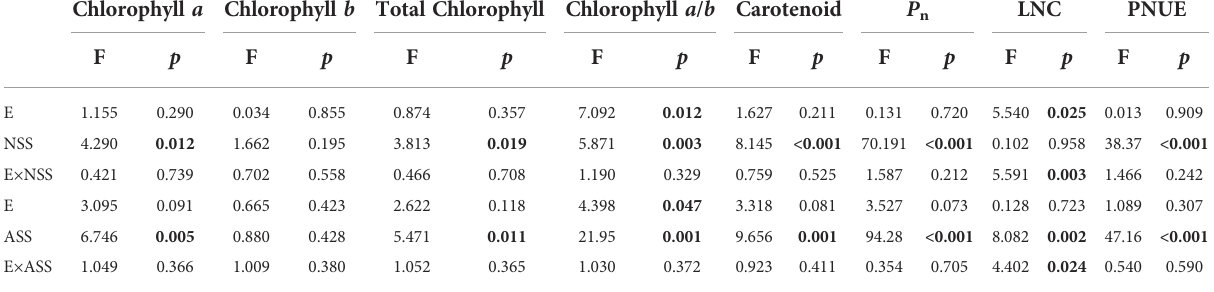
TABLE 4 ANOVA results for the effect of endophyte status and salt stress on photosynthetic pigment content and photosynthetic indicators. Chlorophyll a Chlorophyll b Total Chlorophyll Chlorophyll a / b Carotenoid